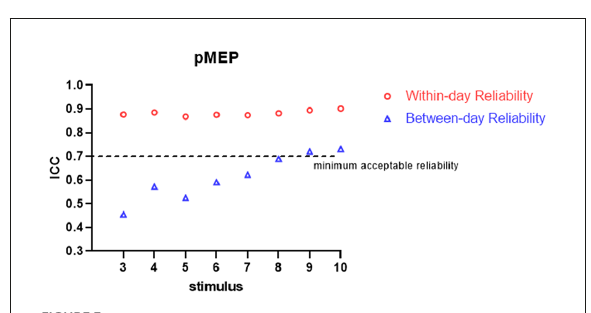
FIGURE3 Within-day and between-day reliability of pMEP. ICC, intraclass correlation coefficient.